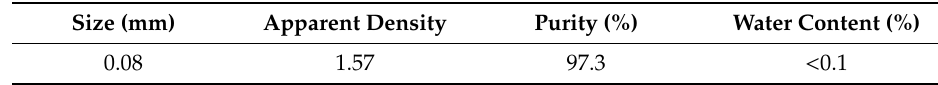
Table 4. Properties of silica sand.